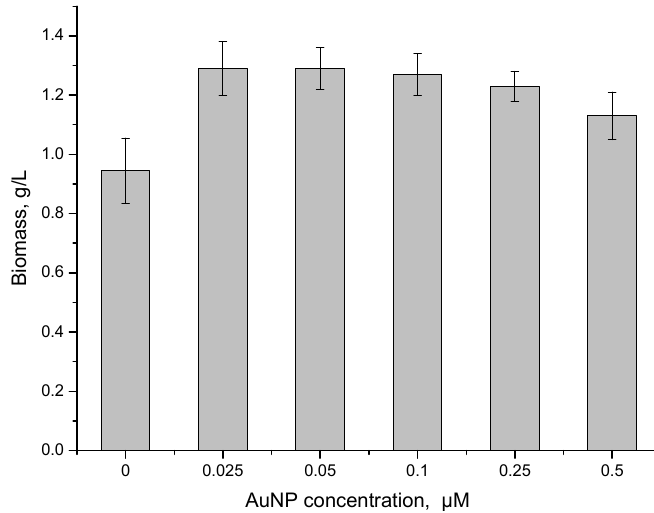
Figure 5. Spirulina platensis biomass at introduction of AuNPs in cultivation medium in a concentration range of 0.025–0.1 µM .